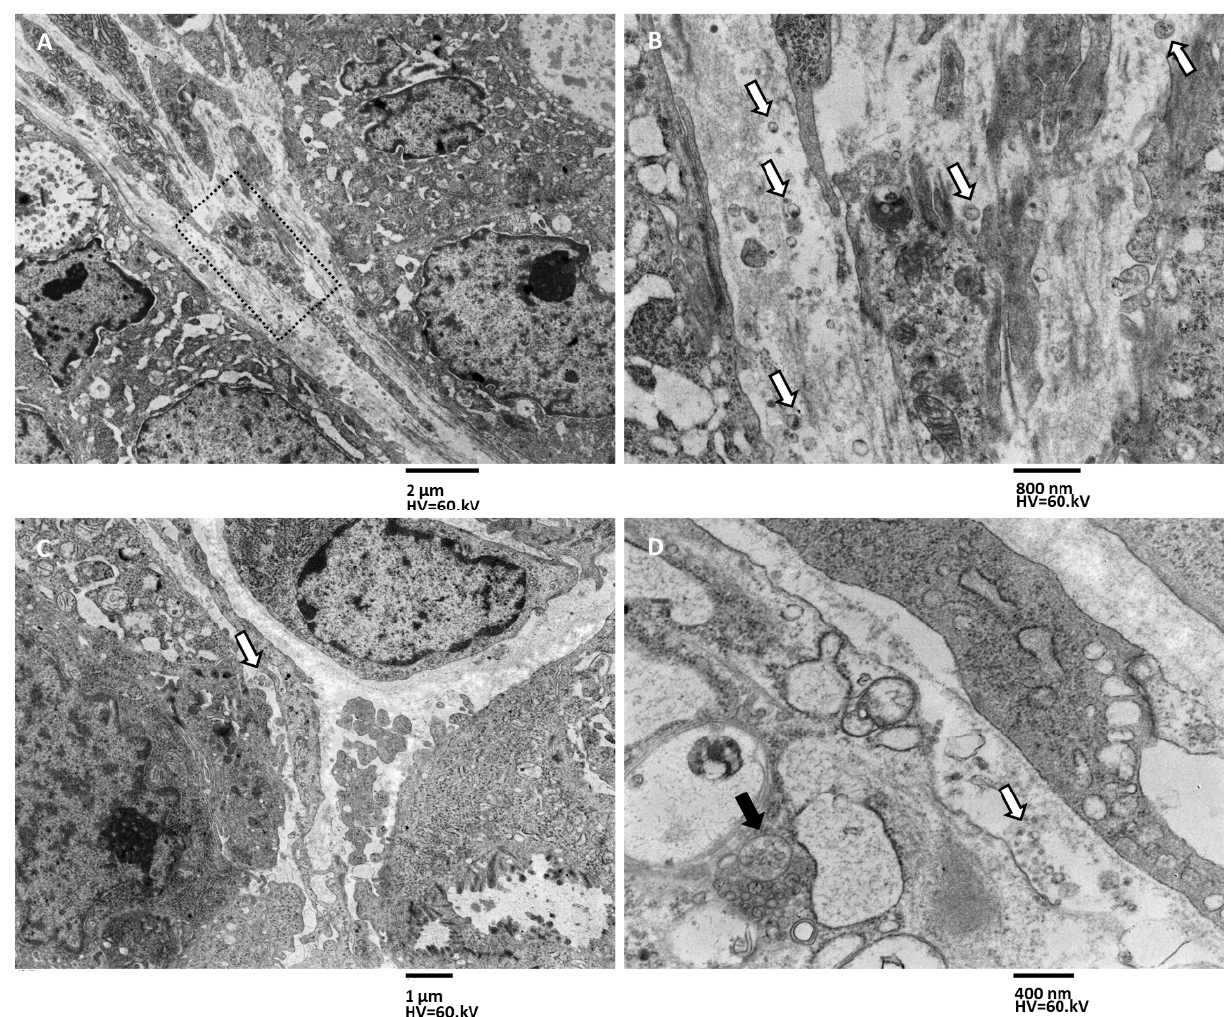
Figure 7. TEM images of exosome secretion pattern in xenografts, basolateral surface secretion. ( A ) An area of xenograft tissue stroma, between pseudocyst lining epithelial cells (on the right and top corner) and deeper tissue cells (on the left bottom corner), is illustrated (the dotted rectangle repre- sents the area of panel B ), magnification 1250×, bar 2 µm. ( B ) Magnification of dotted rectangle area in panel A . Free exosomes (arrows) are visible in the scarce and loose stroma; they are seen both